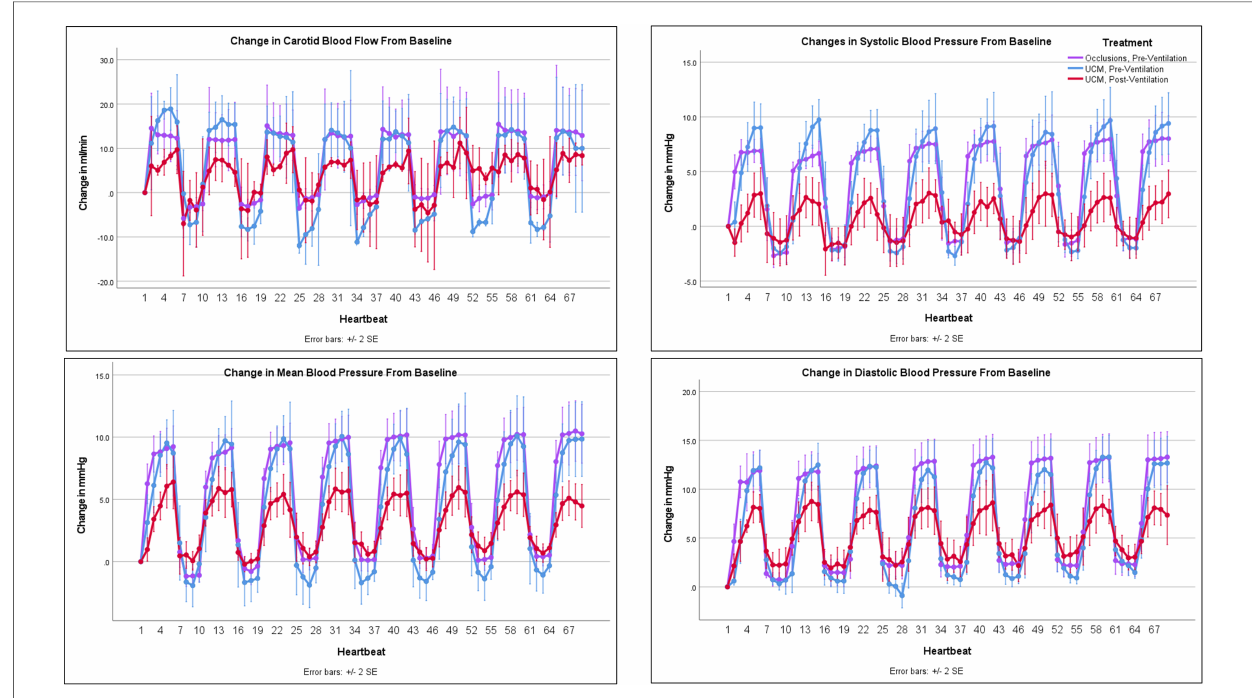
FIGURE 2 Changes in carotid blood fl ow and blood pressure with occlusions and umbilical cord milking (UCM): changes in carotid artery blood fl ow and blood pressure from baseline during umbilical cord occlusions pre-ventilation, UCM pre-ventilation, and UCM post-ventilation.